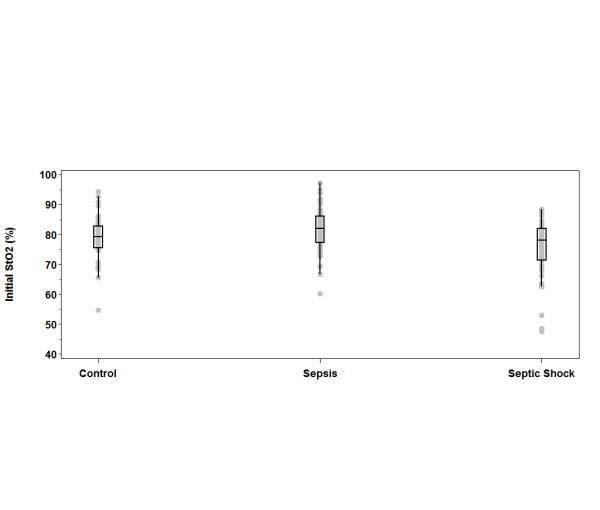
Differences in initial, ischemic and recovery slopes stratified by sepsis severity. The boxplots are for initial tissue oxygen saturation (StO2). The top and bottom lines of the box are the 25th and 75th percentiles, respectively. The middle line is the median. The whiskers extend to the last data point within 1.5 quartile ranges of the box. The gray dots are the individual observed data points.